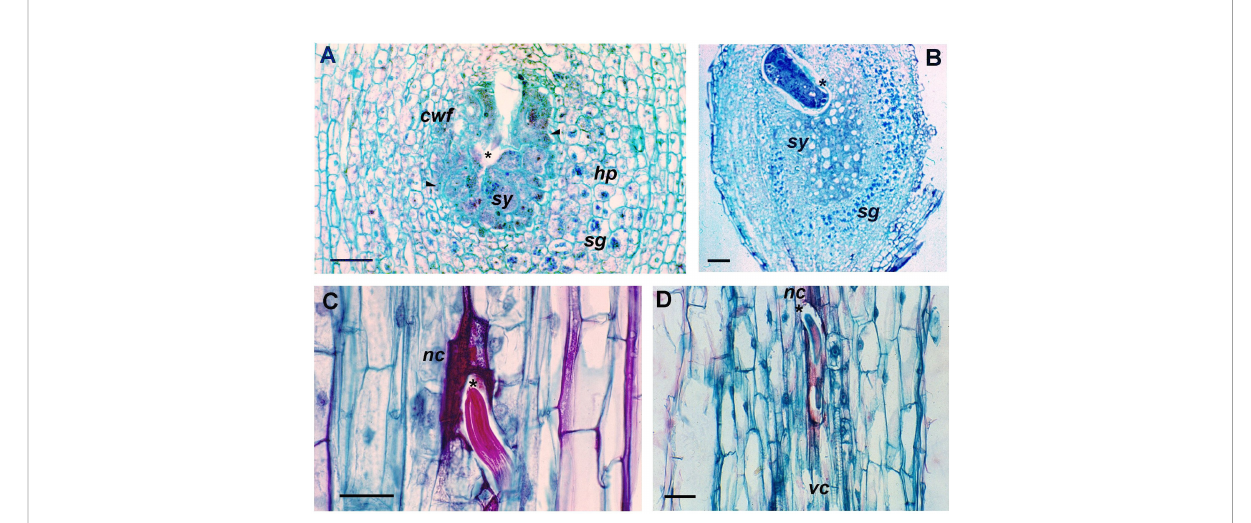
FIGURE 4 Cytological changes induced by Nacobbus aberrans s.l. in potato roots. Longitudinal sections of the susceptible Solanum tuberosum cv. Revolucio ́ n at 10 days after inoculation (dpi) (A) and 30 dpi (B) , showing the syncytium ( sy ) and the cephalic region of the embedded nematode (asterisk). Syncytium with dense cytoplasm, hypertrophied cells (arrowheads) and nucleoli. Cells with two or more nuclei and cell wall fragments ( cwf ) derived from the cell dissolution. Hyperplasia ( hp ) of the tissue surrounding the syncytium with accumulation of numerous starch grains ( sg ). Longitudinal sections of the resistant hybrid B-25 of S. tuberosum Andigenum group, showing the nematode-induced cell necrotic response. At 5 dpi (C) , nematode cephalic region surrounded by necrosed cells ( nc ). At 10 dpi (D) , starved nematode, adjacent to the vascular cylinder ( vc ), surrounded and trapped by dead cells. Scale bars: A = 200 m m; B – D = 100 m